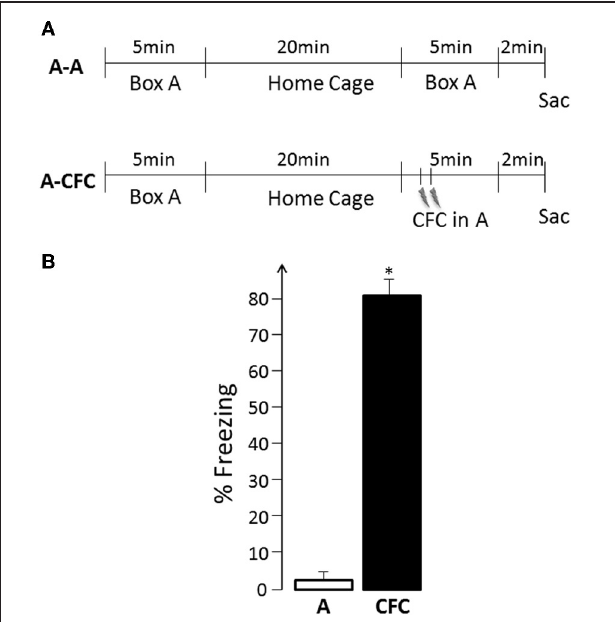
FIGURE 1 | (A) Experimental Design: A, Exploration of the experimental box (no shock); CFC, Contextual fear conditioning in the same box; Sac, Sacrifice; (B) Freezing behavior during the second event- spatial exploration vs. fear conditioning, ∗ p < 0 .